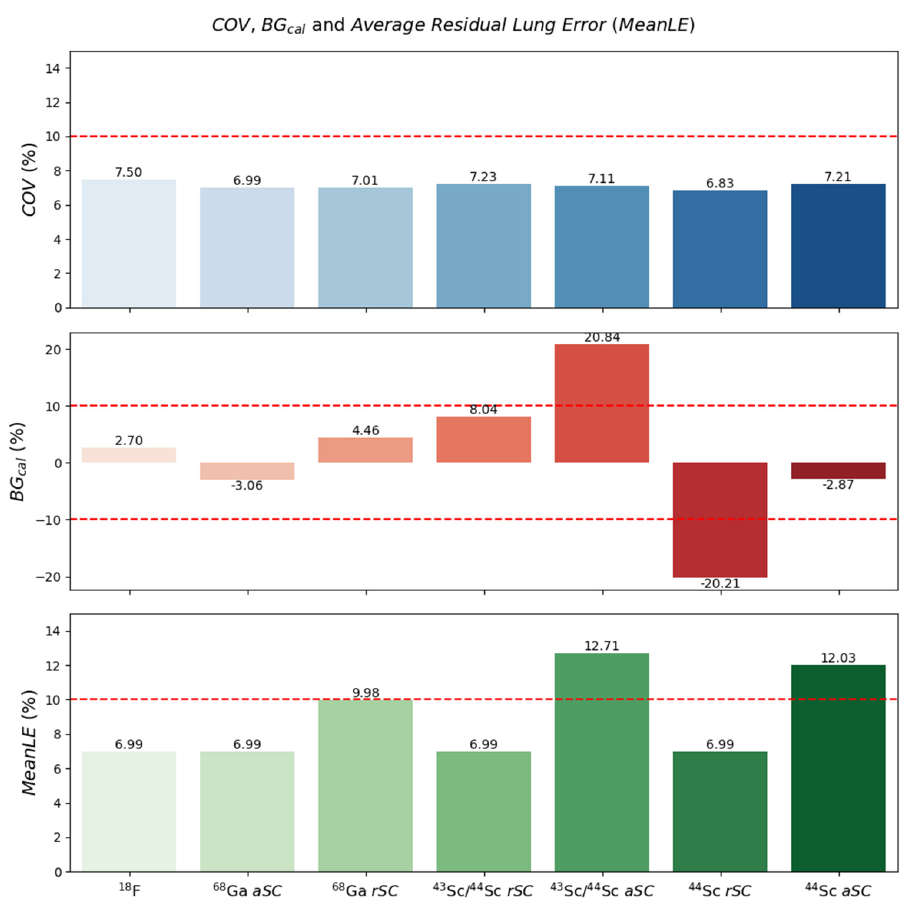
Figure 3. Results obtained for NEMA phantom. Background calibration ( BGcal ), COV and average residual lung error ( MeanLE ) in the NEMA phantom for fluorine-18, gallium-68, ( rSC and aSC ), the scandium-43/44 mixture ( rSC and aSC ) and pure scandium-44 ( rSC and aSC ), respectively. Figure 4 shows the cross-section of the reconstructed phantom obtained for the differ- ent radionuclides and reconstructions used. No noticeable difference was observed for the different radionuclides and reconstructions in terms of image noise and sphere